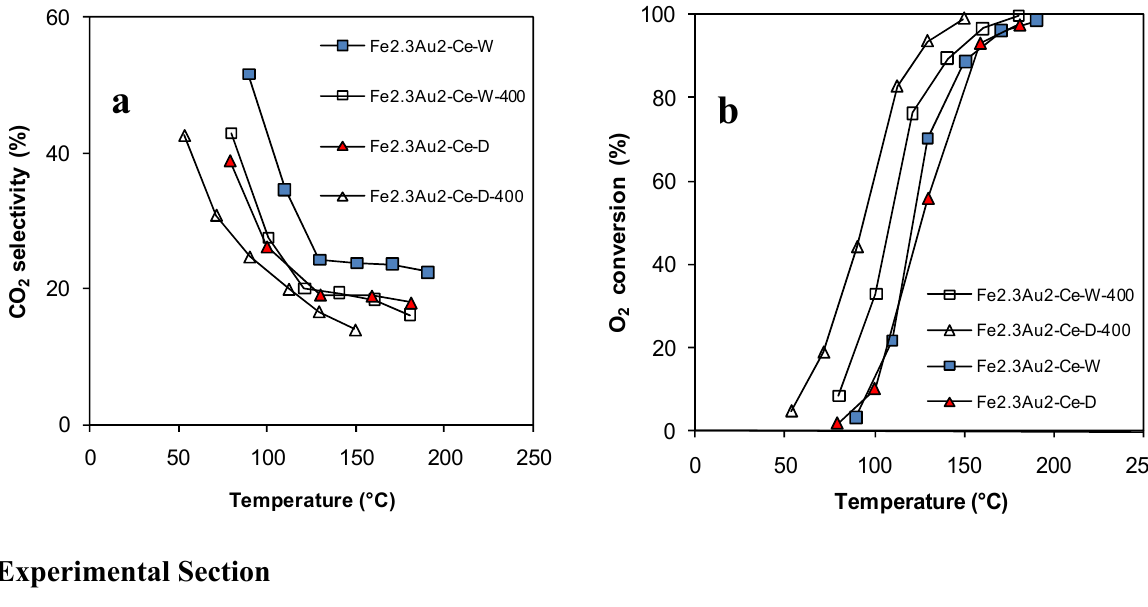
Figure 13. Selectivity towards CO oxidation ( a ) and O catalysts treated under different